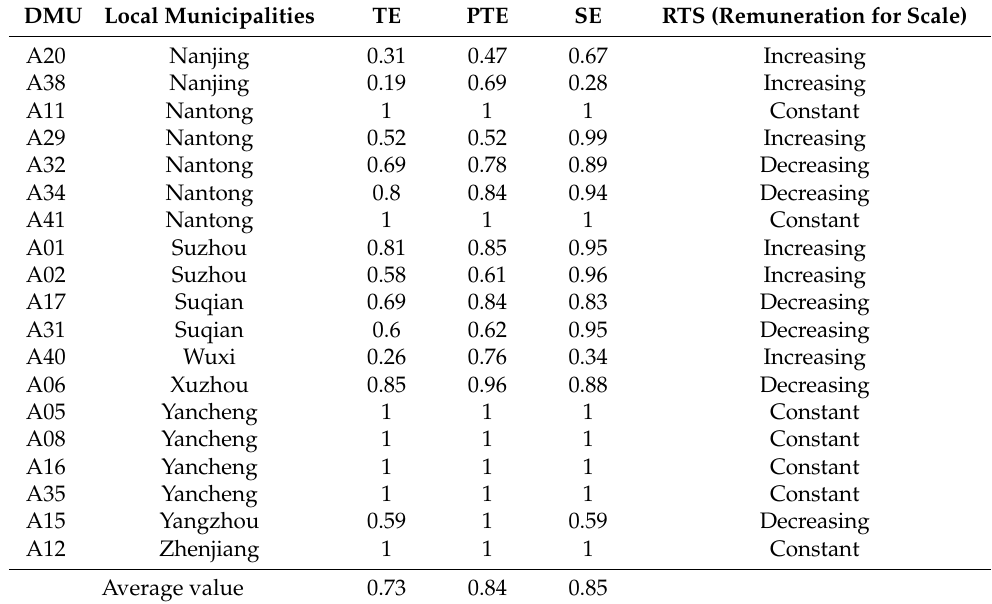
Table 6. Investment efficiency values of the first phase of the 19 projects to meet the demand for electricity (sorted by the